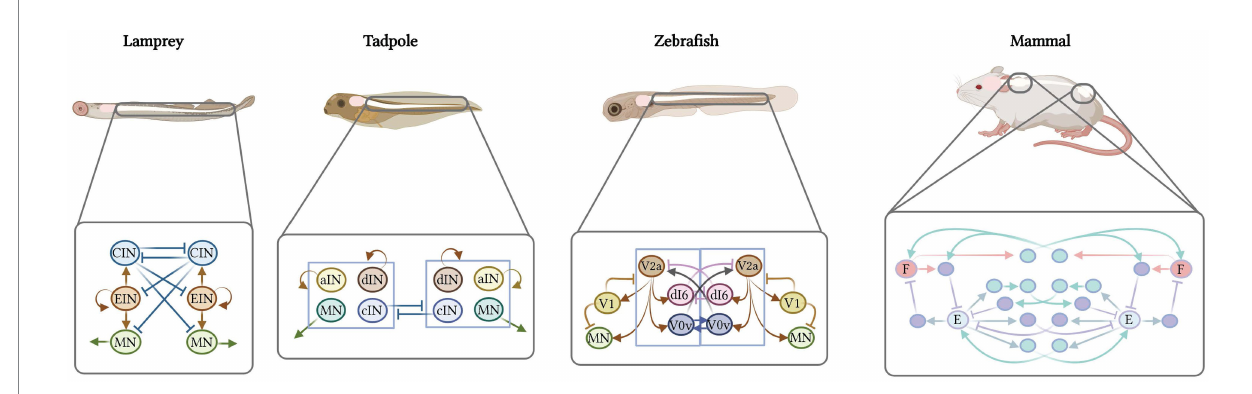
FIGURE 8 Computational models of the lamprey, tadpole, zebrafish and mammal spinal cord networks. The region of the spinal cord modeled is indicated. Far left: lamprey CPG with excitatory interneurons (EINs), inhibitory commissural interneurons (CINs), and motor neurons (MNs). Middle left: CPG model of the tadpole with the same neuron types as the lamprey plus additional ipsilateral inhibitory neurons (aINs). Middle right: CPG of the zebrafish larva at a stage when it can perform beat-and-glide swimming. Compared to the tadpole model, this model has additional contralateral excitatory neurons. Far right: model of the mammalian spinal cord showing connections between right and left rhythm generators (red: flexor unit, F; blue: extensor unit, E) at the limb level. Turquoise circles represent excitatory interneurons while purple circles represent inhibitory